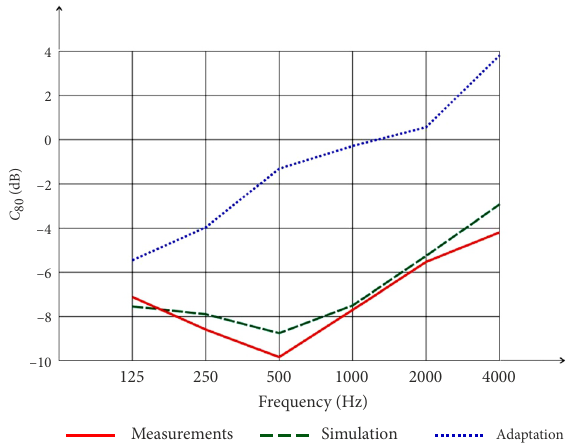
Measurements Figure 14. Graph of clarity index C 80 in the frequency range – comparison of in situ measurements, simulation and simulation with acoustic adaptation